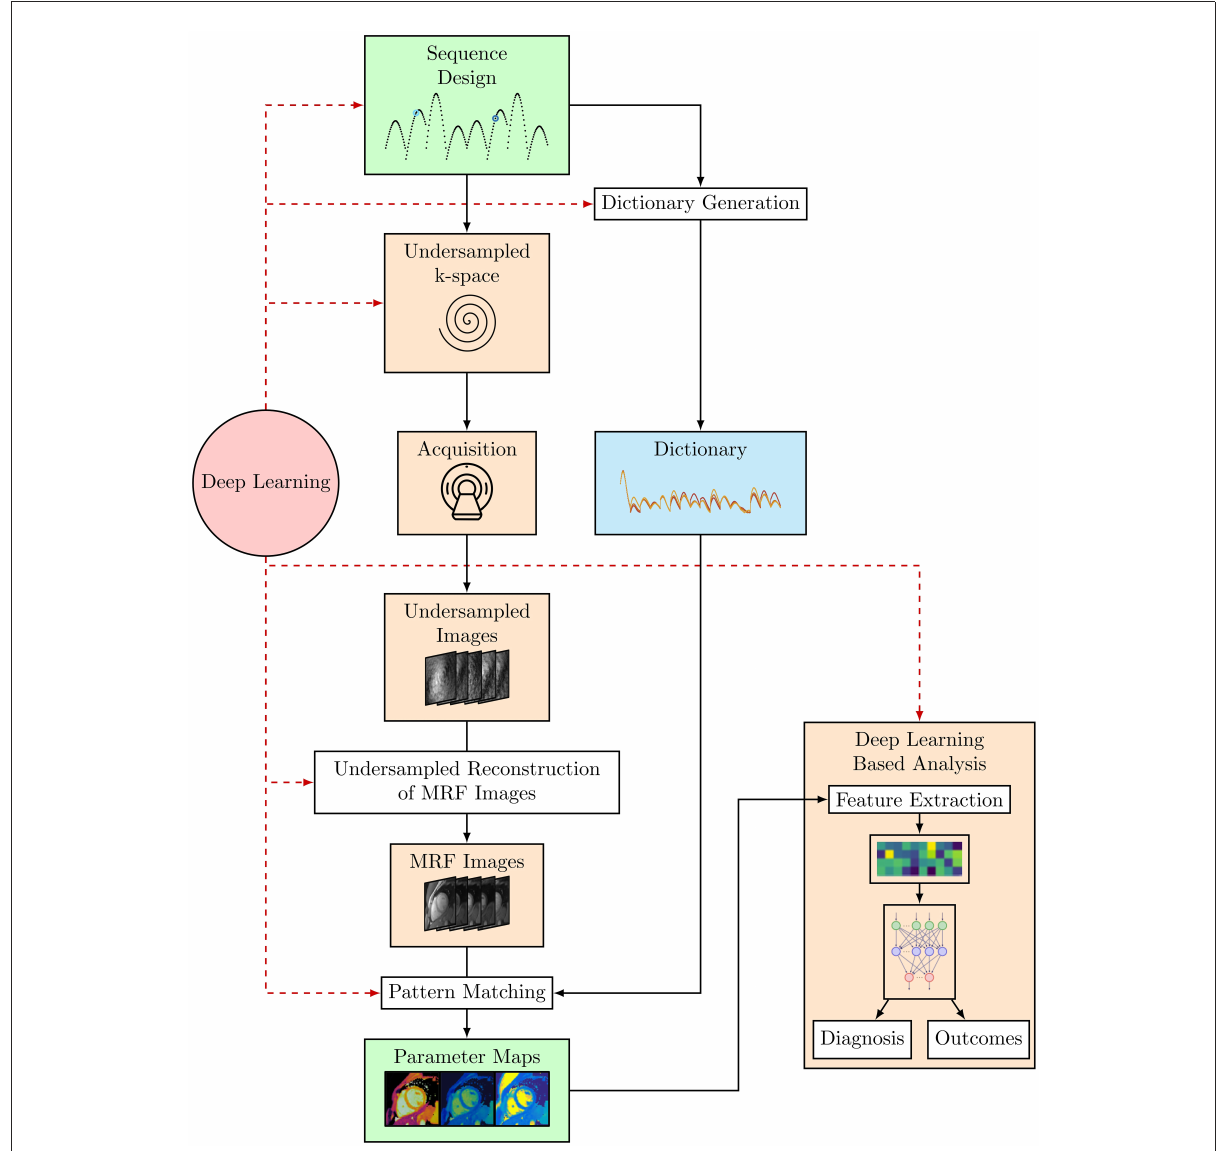
FIGURE3 The cardiac MRF workflow from sequence design and optimization through to parameter map estimation and potential uses of cardiac MRF data, where DL-based analyses such as Radiomics can be used to provide a diagnosis or predict outcomes. Black arrows indicate the flow of steps taken in the cardiac MRF workflow. The red dashed arrows indicate steps where DL methods have or could be applied within this